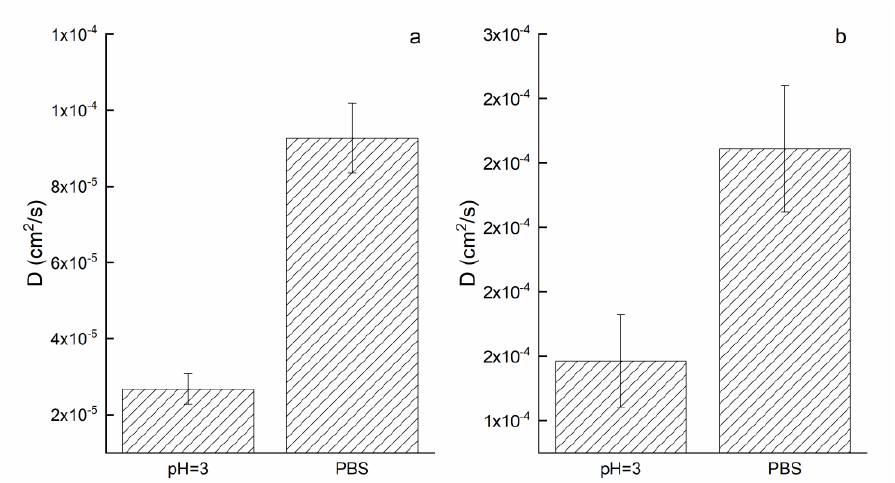
Figure 8. Diffusion coefficients (short ( a ) and long ( b ) times) of the electrospun systems in different media.